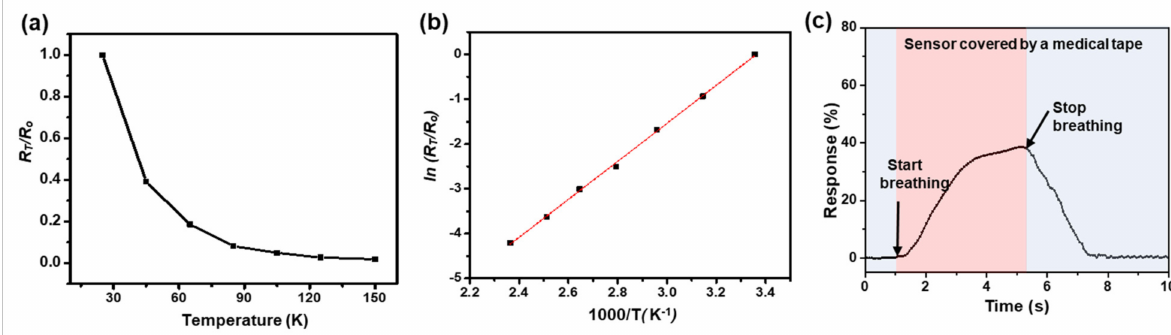
Figure 5. ( a ) Electrical resistance variation of the breath sensor corresponding to temperature change only. ( b ) Data fitting to determine the thermal sensitivity index (B-value) of the breath sensor. ( c ) Response curve of the breath sensor covered by a medical tape to the normal breath rate at 50 ◦